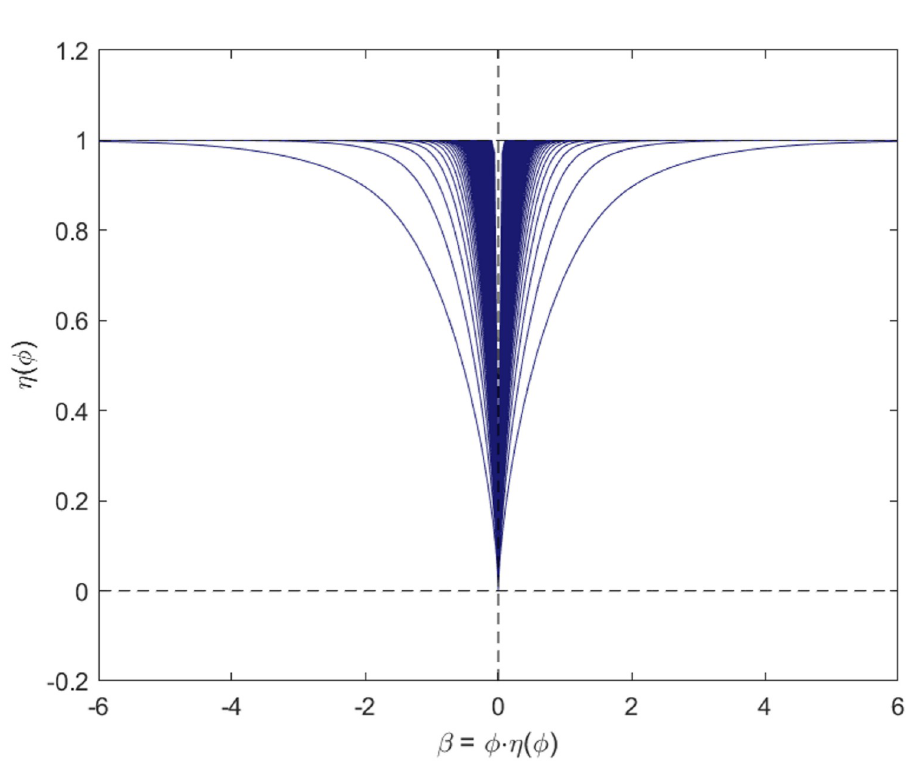
Fig 3. Plot of β and η ( ϕ ). This plot displays relationship between true coefficients and penalty term. i i